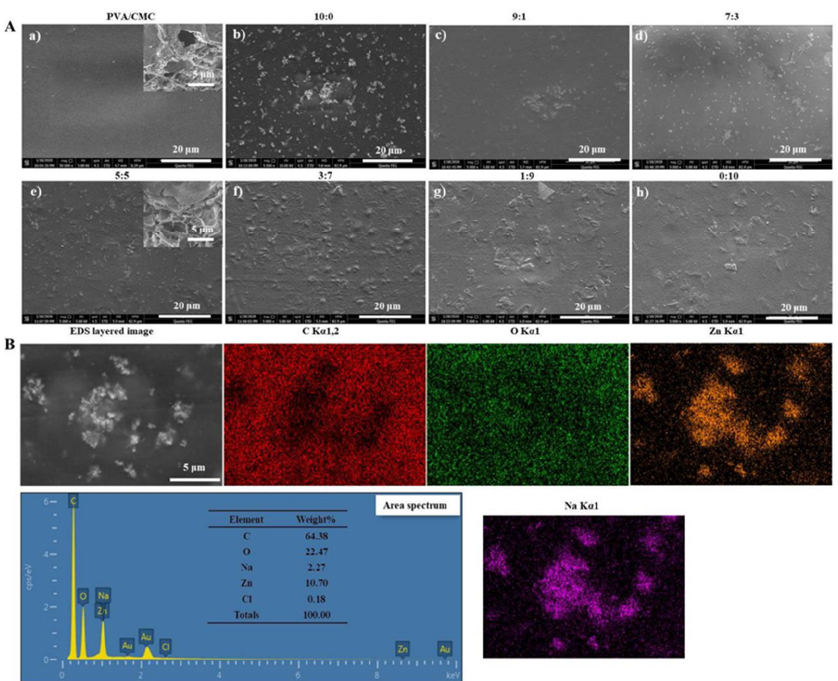
Figure 2. ( A ) SEM (Scanning Electron Microscope) images of ( a ) PVA/CMC film, ( b – h ) and PVA/CMC/ZnO NPs/ x GnP composite films (with different mass ratios of ZnO NPs-to- x GnP; ultrasonication time, 30 min). Inset shows cross-sectional SEM images of the PVA/CMC/ZnO NPs/ x GnP composite film and PVA/CMC film; ( B ) EDS images of PVA/CMC/ZnO NPs/ x GnP (ZnO NPs: x GnP = 7:3) composite film (ultrasonication time, 30